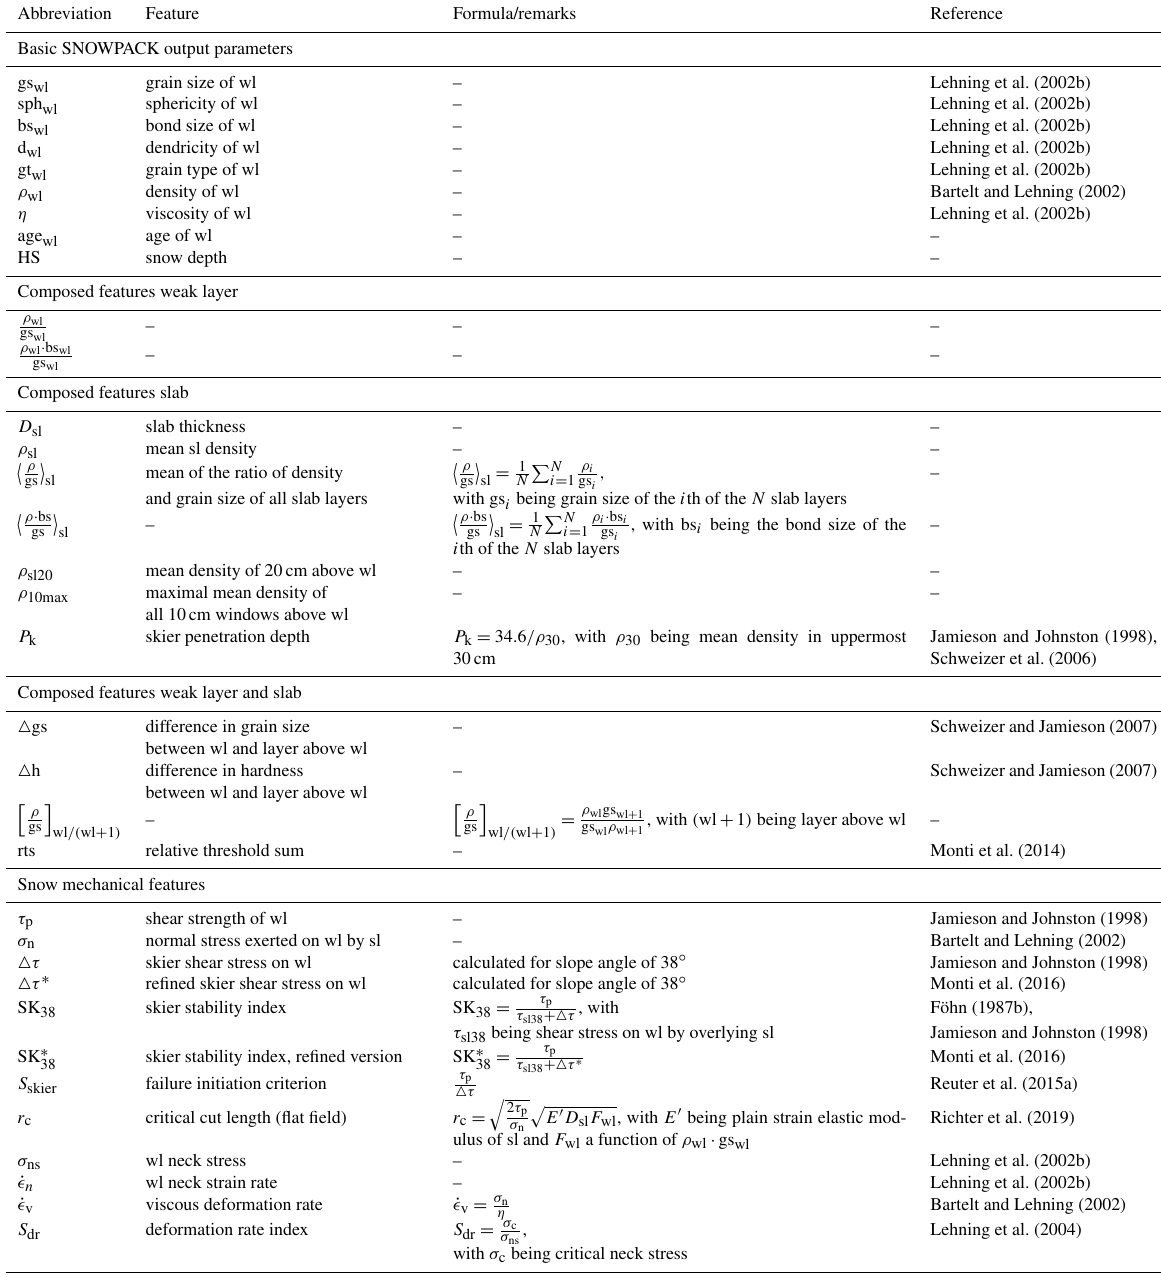
Table B1. Table with all features describing slab (sl) and weak layer (wl)